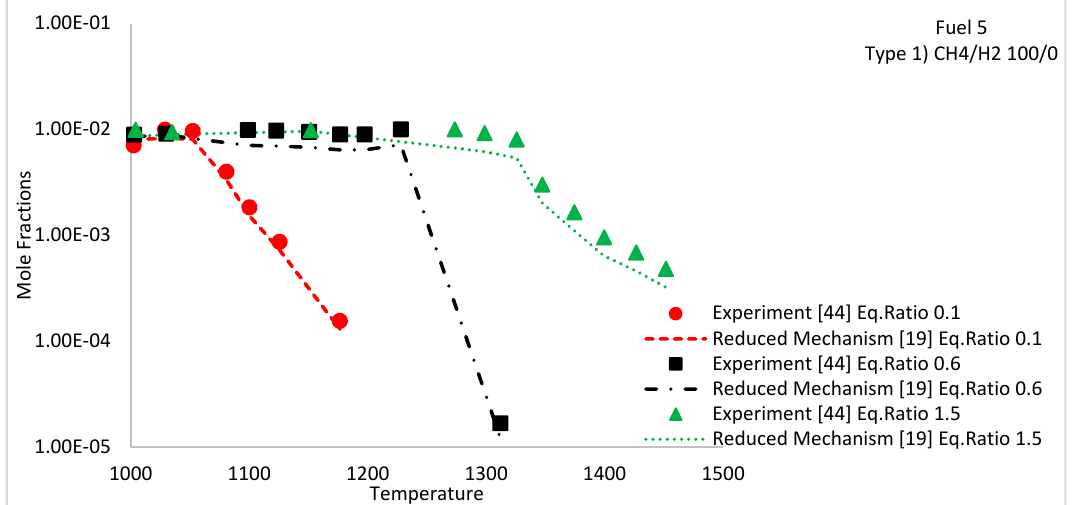
Figure 7. Comparison of the calculated CH 4 profiles by using the reduced mechanism [19] and the experimental measurements from Reference [44] for 100% methane mixture at pressure 1 bar, temperatures 900–1450 K and eq.ratios 0.1, 0.6 and